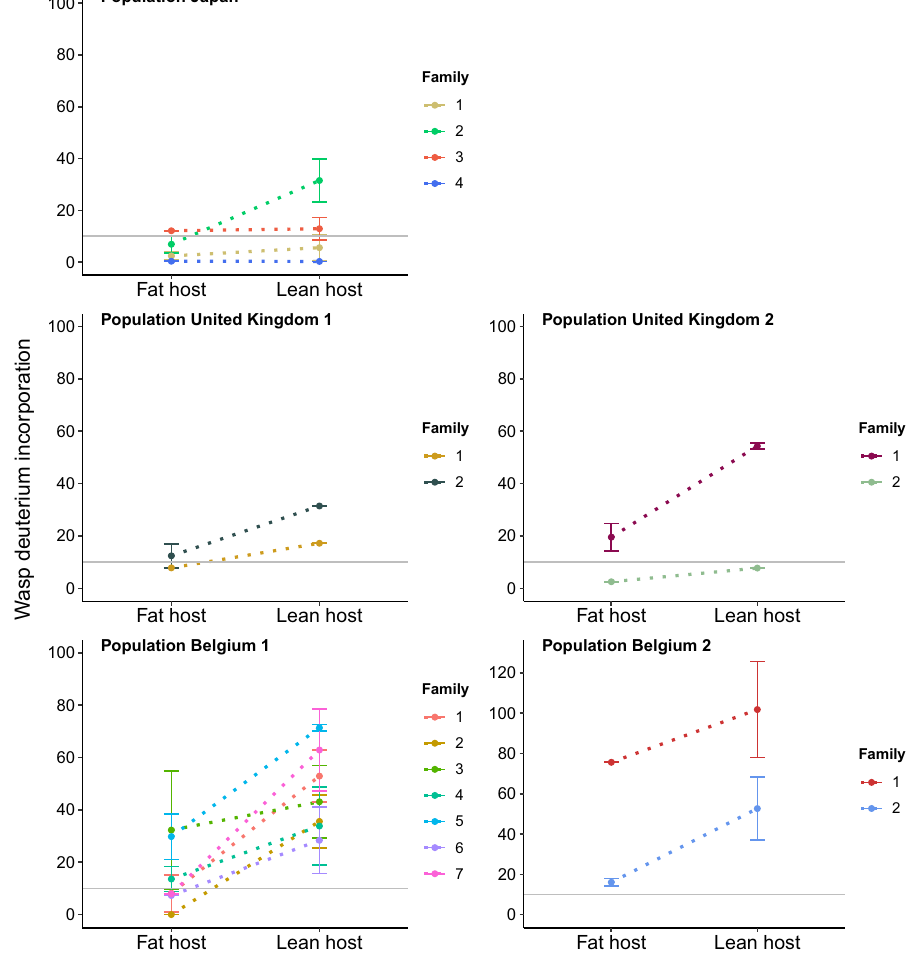
Figure 1. Phenotypic plasticity in five field-caught wasp populations. Incorporation of stable isotopes (%) into the fatty acid fraction (summed for C16:0, C16:1, C18:0, C18:1, and C18:2), averaged for the offspring from 17 families (± standard error; n = 138) developing in a fat-rich environment (fat host Drosophila melanogaster , left in each graph) and in a fat-poor environment (lean host D. simulans , right in each graph). The horizontal gray line indicates the threshold above which active lipogenesis takes